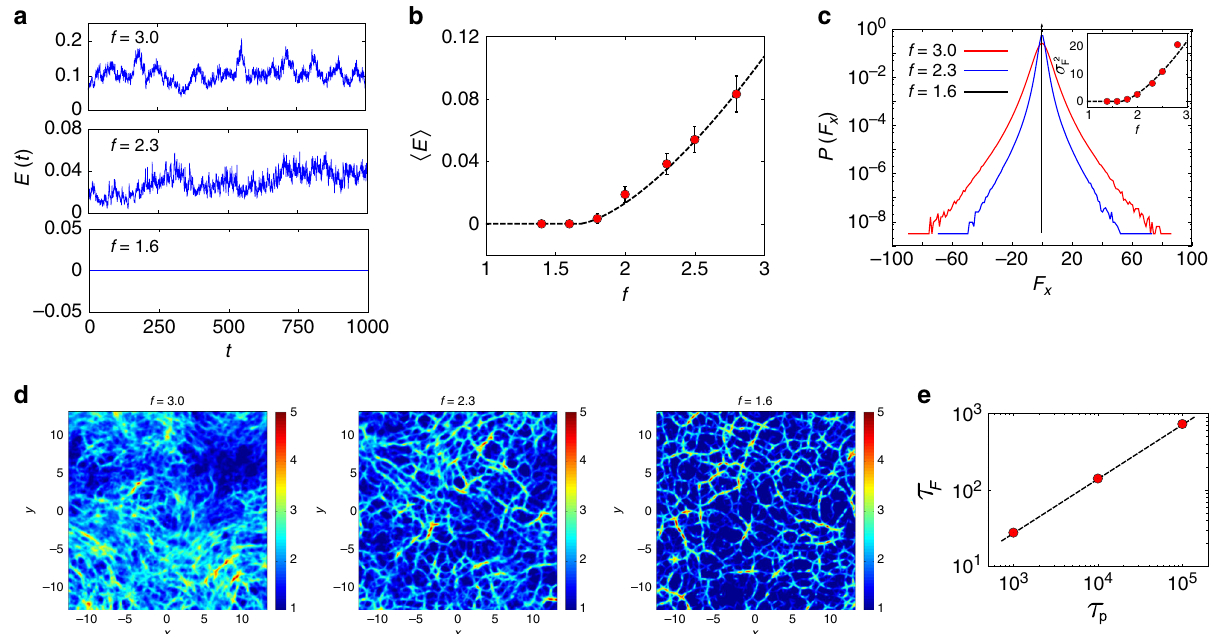
Fig. 5 Jamming at in fi nite τ p and force chains. a Kinetic-energy time series as f is lowered, shows complete jamming at f ≈ 1.6. b The variation of the mean kinetic energy with f , shows a continuous transition at f = f * ( ∞ ) ≈ 1.6, that goes as 〈 E 〉 ~ ∣ f − f * ( ∞ ) ∣ 3/2 , shown with dashed line. Error bars denote a standard deviation over 32 independent initial conditions. c The probability distribution of the x component of the total force acting on a particle (passive LJ + active forces), P ( F x ) at different values of f , is broad with exponential tails, with a width that decreases continuously with f (inset). From each particle, we have subtracted the centre-of- mass force. At the jamming transition, f = f c , the distribution becomes a delta function at F x = 0, the force-balanced state. d At the jamming critical point, the forces on the particles are distributed along force chains, as highlighted in the colour map of thresholded forces. The forces are evaluated using a local coarse graining of inter-particle forces acting along each bond between local neighbours, time averaged over δ t = 5. The colour represents the strength or magnitude of the forces (shown in the colour bar). Away from the jamming critical point, either by increasing f keeping τ p fi xed, or decreasing τ p keeping f fi xed, the force chains dynamically remodel whilst still being embedded in a static contact network. This is seen as a blurring of the colour map of thresholded forces (at f = 3.0 and 2.3) away from the sharp force chains at f = 1.6. e The dynamics of the force chains show a distribution of lifetimes in the force-balanced con fi guration. The mean lifetime of the force-balanced con fi gurations, computed for f = 1.6 at varying τ p , diverges as one moves towards the jamming critical point as a power law, τ F (cid:5) τ z p , with z = 0.71 (shown with dashed